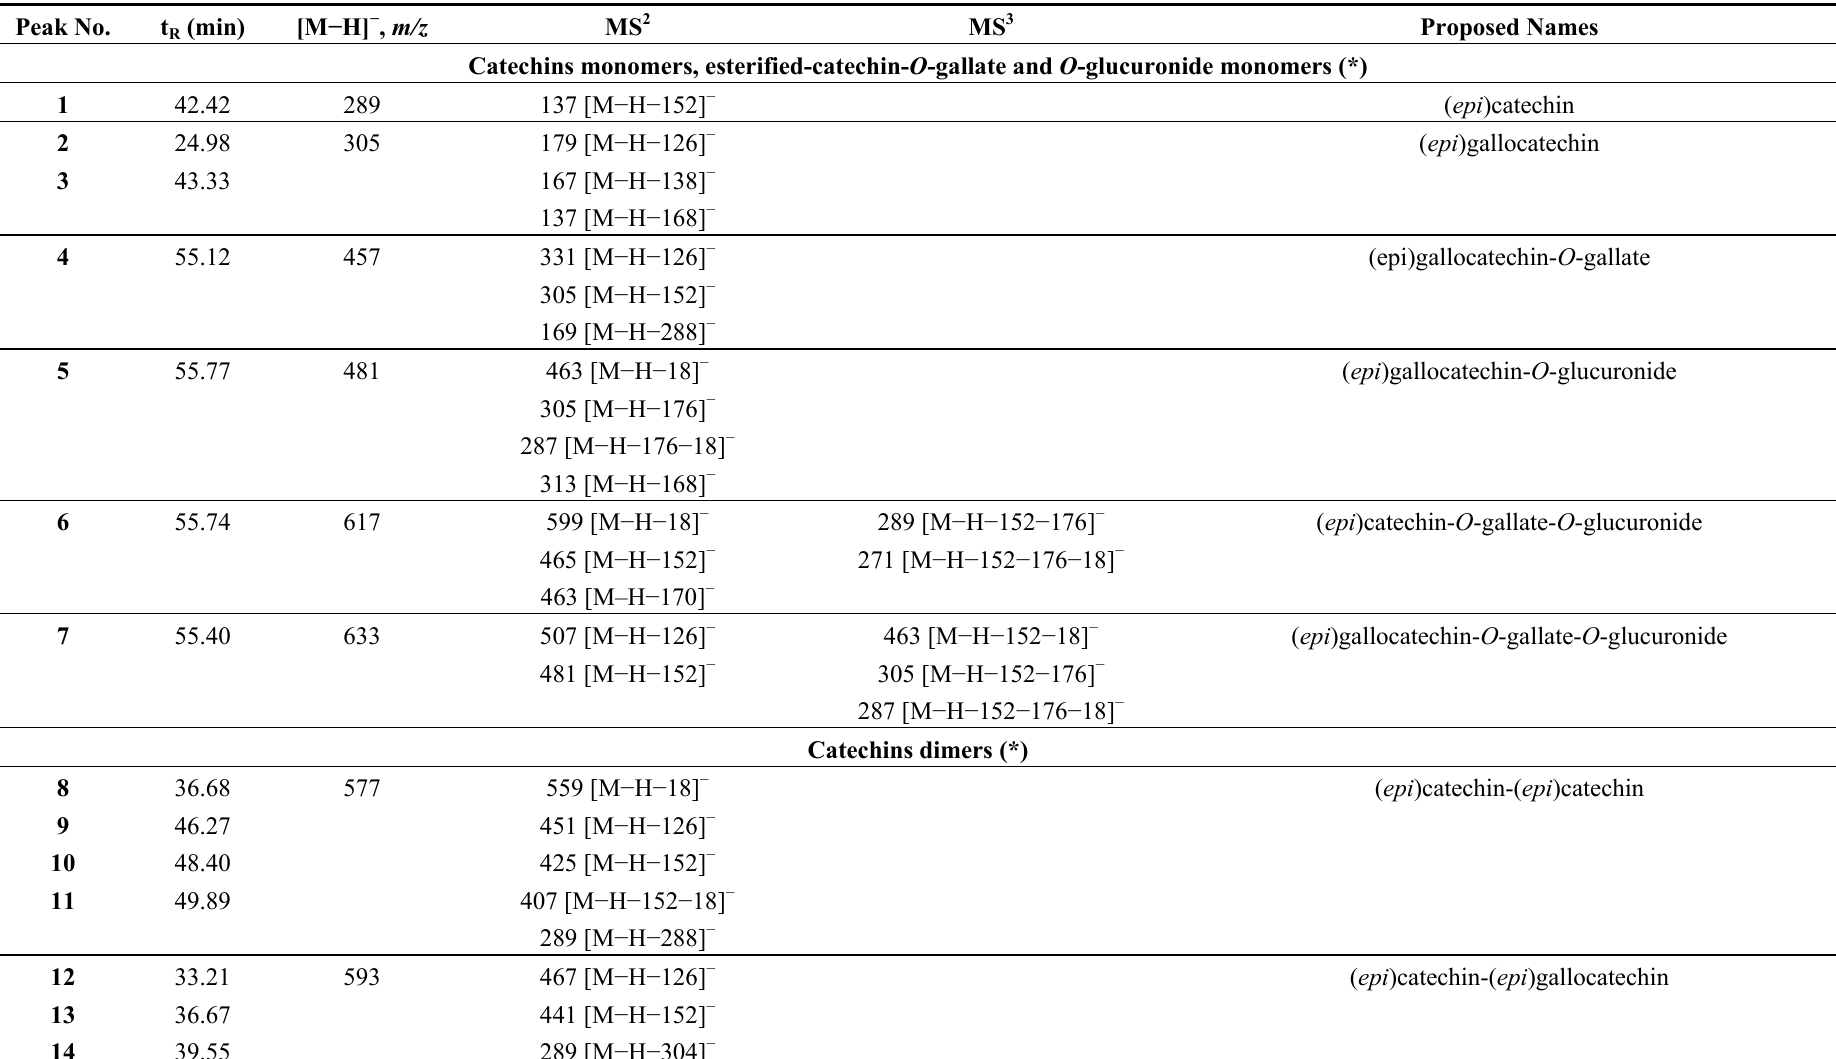
Table 1. Peak number, retention time, m/z [M − H] − ion, MS n fragments of the compounds obtained by FIA-ESI-IT-MS n and HPLC/ESI-IT-MS analysis of P. biglobosa roots and barks. Peak